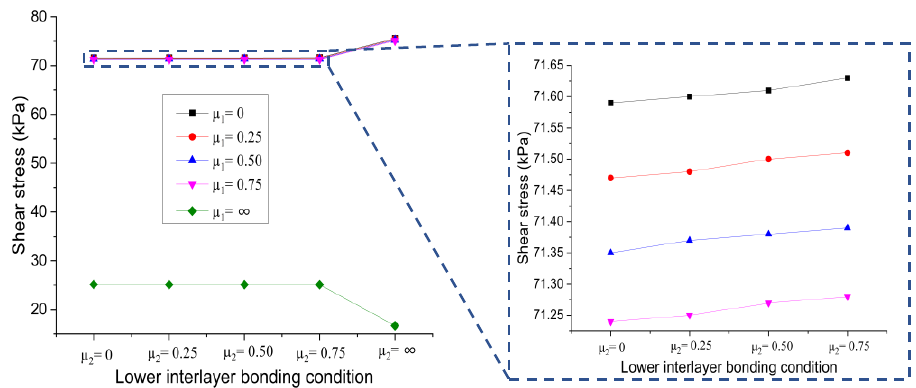
Figure 11. Influence of lower interlayer bonding condition on shear stress at the bottom of upper layer.